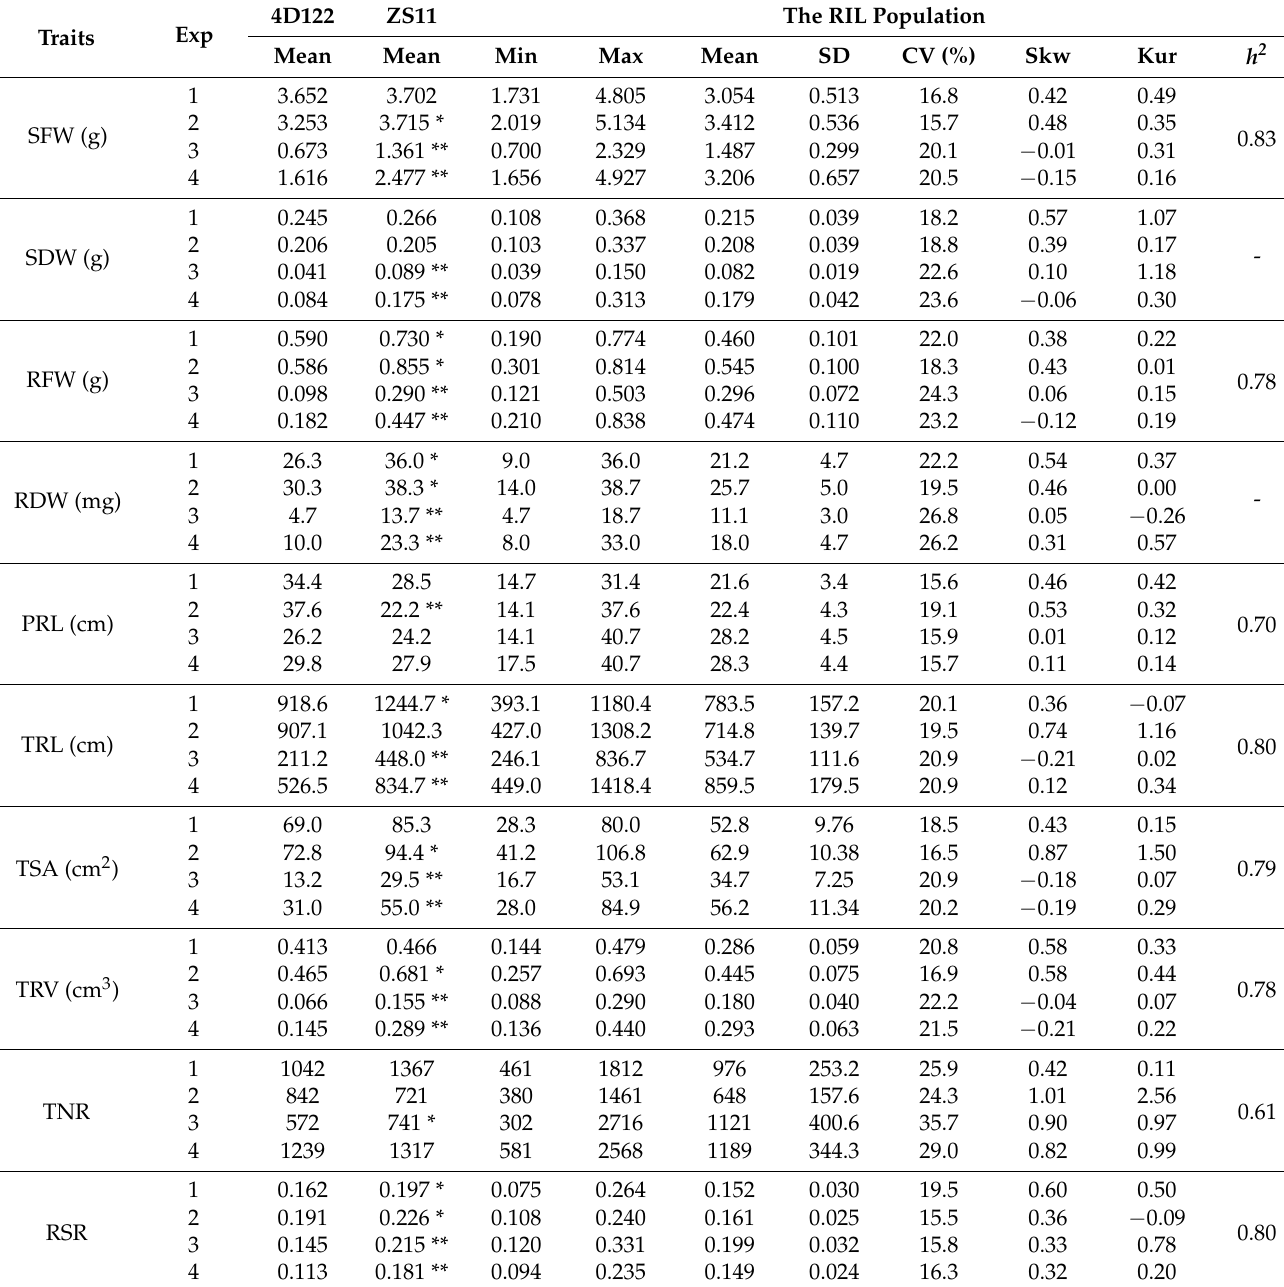
Table 1. Descriptive statistics for the investigated root and shoot biomass